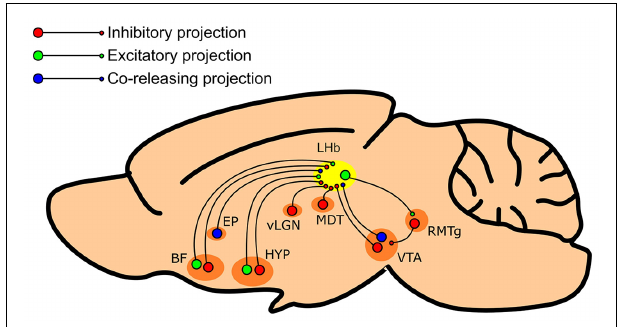
FIGURE 1 | Summary schematic of regions which provide inhibitory input to the LHb. The LHb (shown in yellow) receives inhibitory input from various regions such as the entopeduncular nucleus (EP), the basal forebrain (BF), the lateral preoptic area and lateral hypothalamus of the hypothalamus (HYP), the ventral lateral geniculate nucleus/intergeniculate leaflet complex of the thalamus (vLGN), the mediodorsal thalamus (MDT), and the ventral tegmental area (VTA). These afferent structures may feature both inhibitory (shown in red) and excitatory (shown in green) neuronal populations, primarily inhibitory populations, or GABA/glutamate co-releasing neurons (shown in